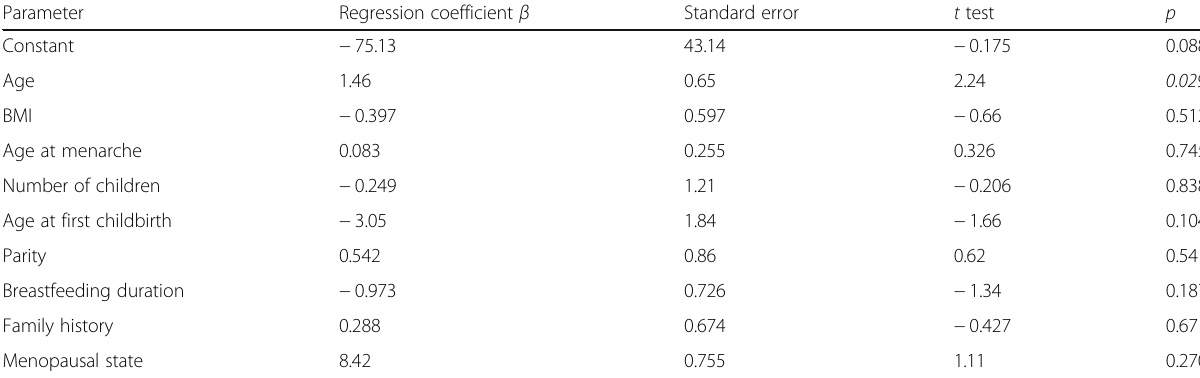
Table 3 Univariate linear regression analysis of the association of p14/ARF methylation percentage with breast cancer risk factors Parameter